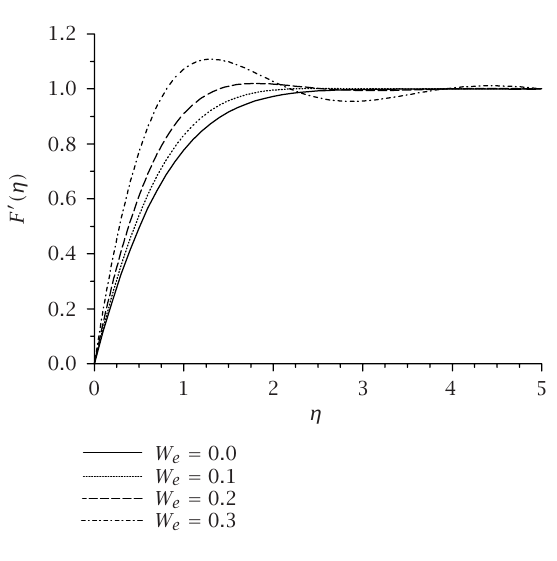
Figure 3.1 . Variation of F (cid:6) (η) with W e .